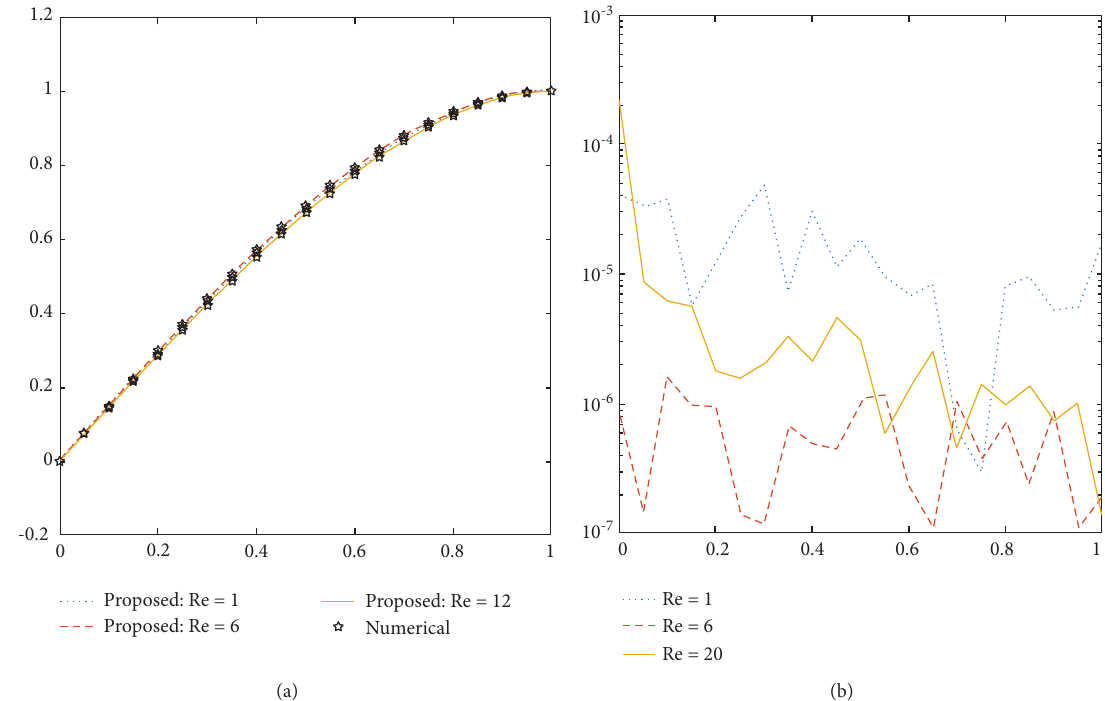
Figure 6: Evaluation of proposed LMA-BANN with the numerical reference results for the MPFPCMI scenario 1: (a) outcomes for different value of Re in f ; (b) error plot of Re in f